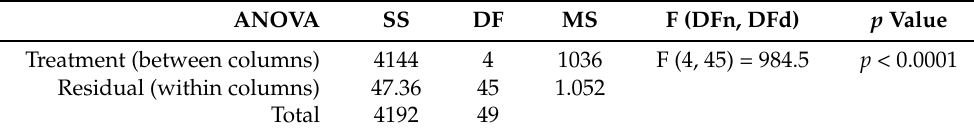
Table 3. Evaluation of the ANOVA test based on the recorded results.